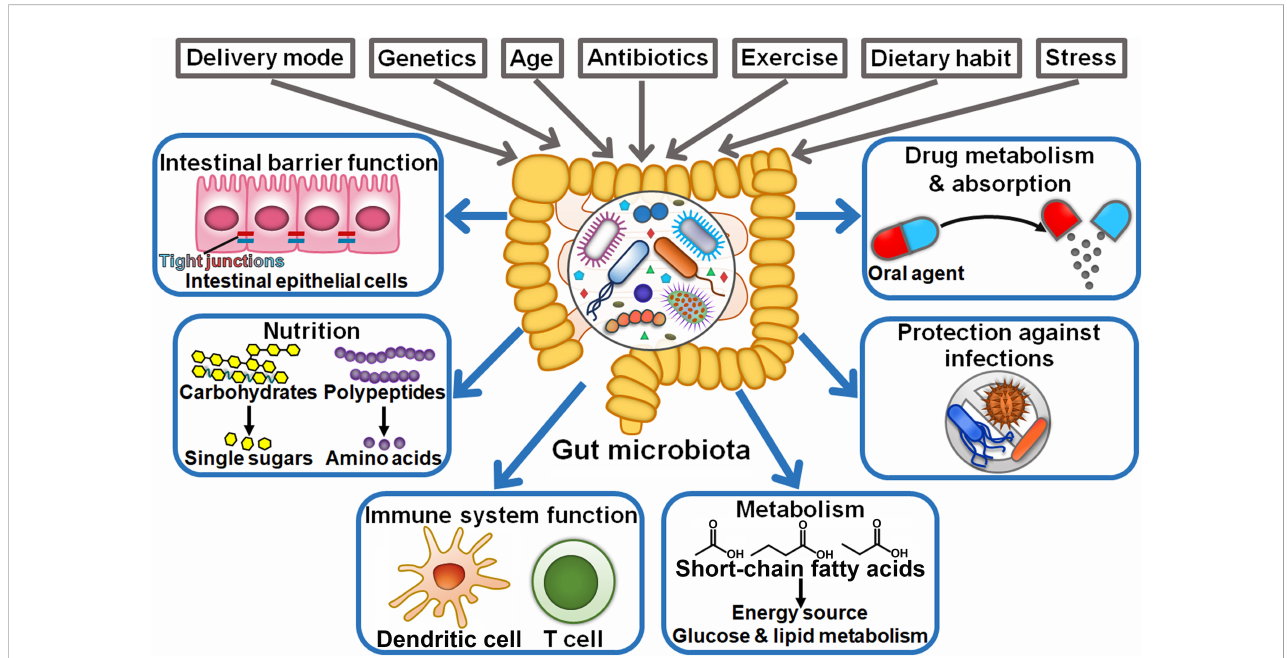
FIGURE 1 Schematic representation of the bene fi cial functions of the gut microbiota. Intrinsic and extrinsic factors can alter the composition of the gut microbiota, including the mode of delivery at birth, host genetics, age, antibiotics, exercise, dietary habit, and stress. The gut microbiota plays a critical role in human health, such as preservation of intestinal barrier integrity, breaking down food compounds (e.g., carbohydrates and proteins), supplying essential nutrients, and regulation of immune system development. Commensal microbes also coordinate energy, glucose and lipid metabolism. Importantly, they confer protection against invading pathogens. In addition, intestinal microbes have the ability to in fl uence the bioavailability, absorption and therapeutic ef fi cacy of oral